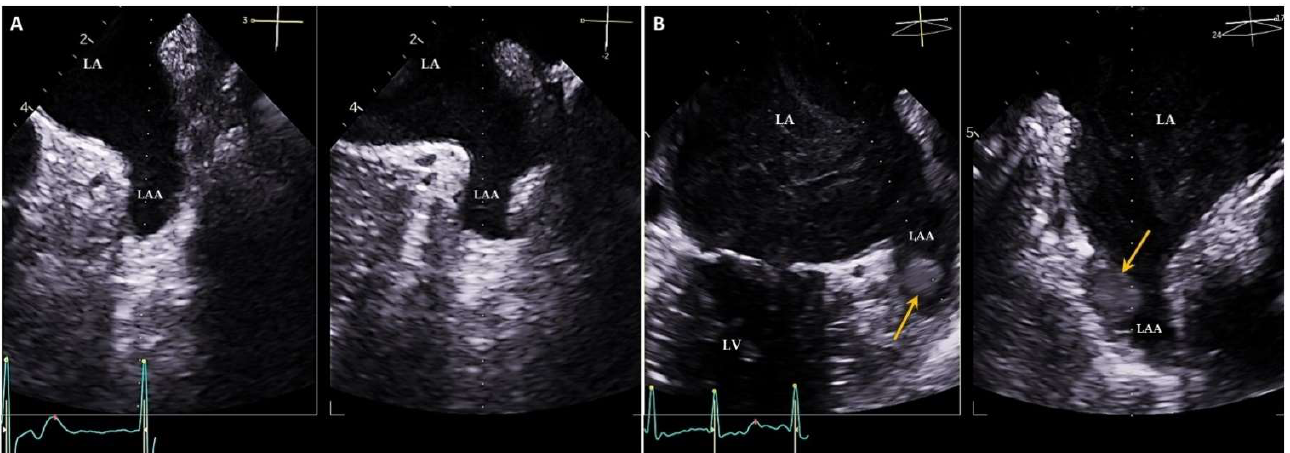
Figure 5. Analysis of LAA prior to electrical cardioversion with 2D TEE multiplane mid-esophageal view to assess the stroke risk. LAA without thrombus ( A ) and with thrombus inside (yellow arrows; ( B )). LAA: Left atrial appendage; LA: Left atrium.